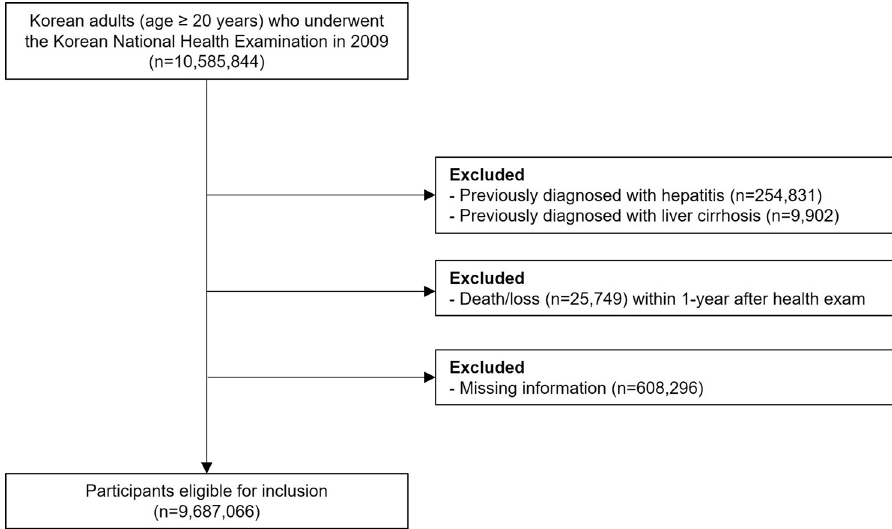
Figure 1. Flow chart of the study